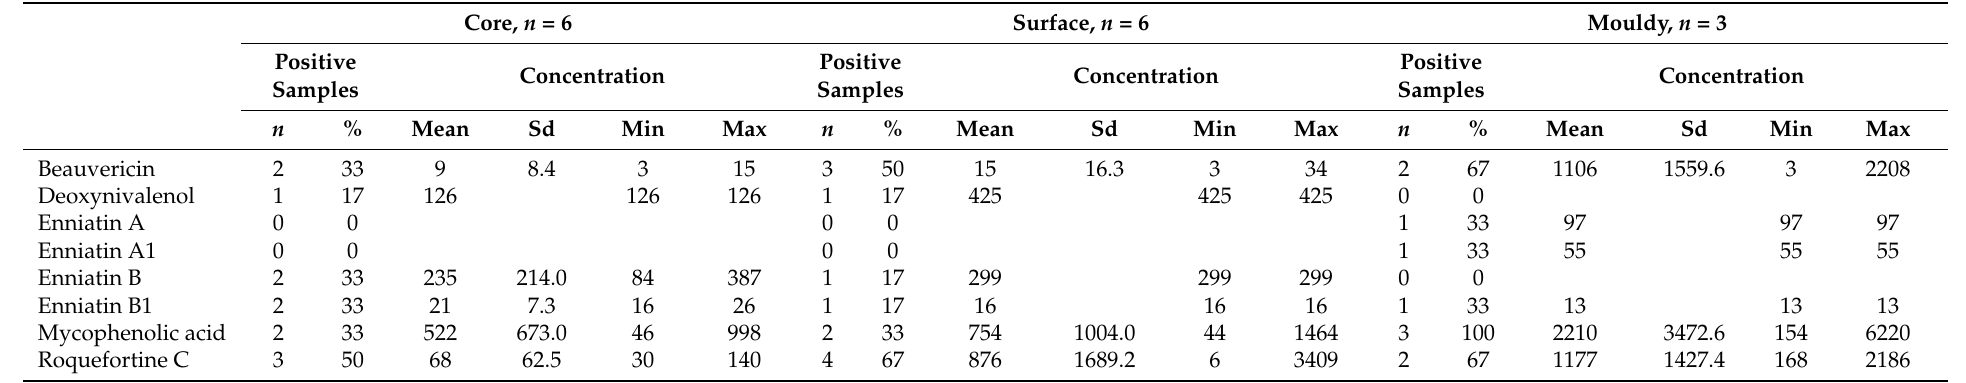
Table 4. Incidence and concentrations of mycotoxins ( µ g/kg dry matter) in whole-crop cereal silage. Values represent only samples where the specific mycotoxin was